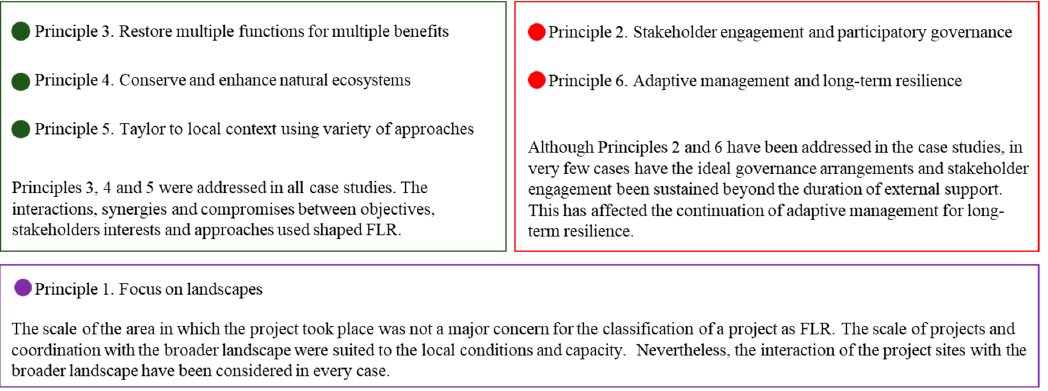
Figure 1. How the forest and landscape restoration (FLR) principles are being incorporated in projects.